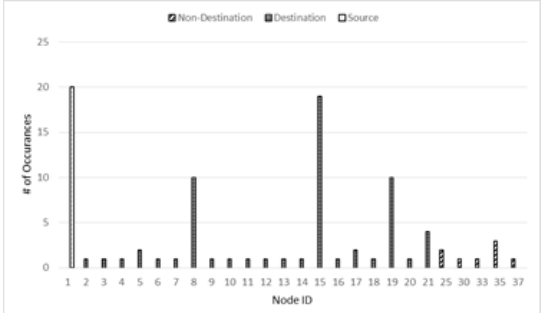
Fig. 17. Number of Paths Each Node Participates in for a Multicast Tree with 40 Nodes and 20 Destinations